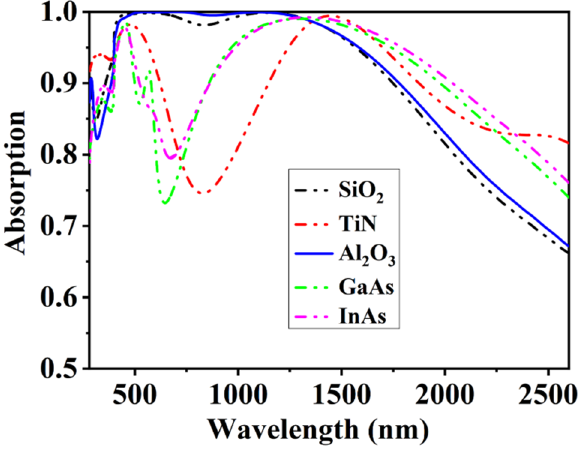
Figure 10. Absorption spectral of different dielectric materials.